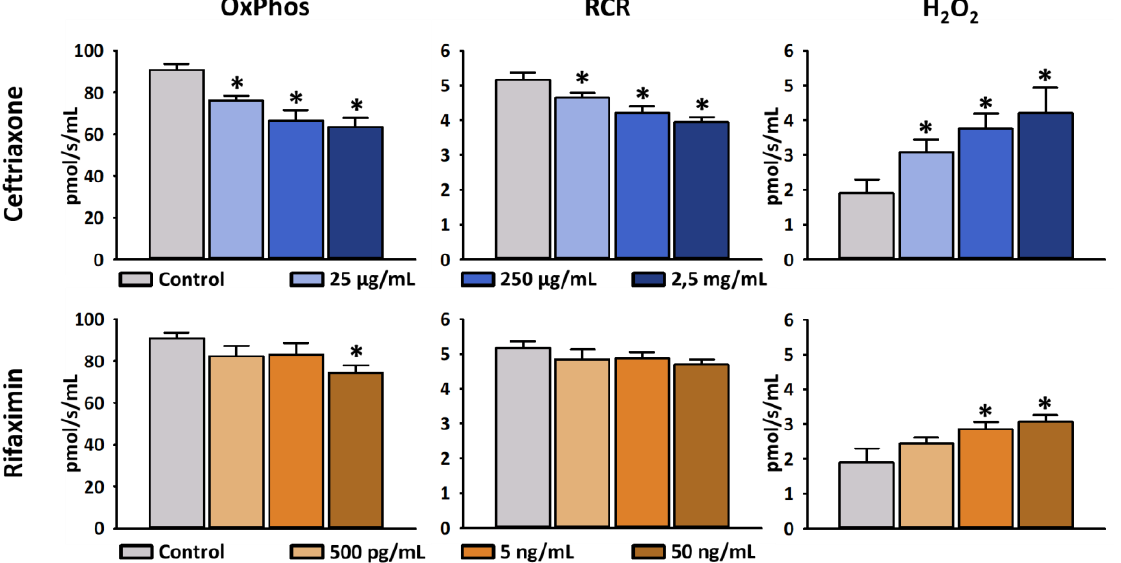
Figure 1. Effects of Ceftriaxone and Rifaximin on oxidative phosphorylation (OxPhos), respiratory acceptor control ratio (RCR) and hydrogen-peroxide (H 2 O 2 ) production of isolated mitochondria. Concentrations of antibiotics are based on their peak plasma concentration following the admin- istration of a single dose (250 µg/mL Ceftriaxone or 5 ng/mL Rifaximin) and tenfold higher or lower concentrations for comparison. Darker shades indicate higher concentrations. Blue columns: Ceftri- axone treatment; Orange columns: Rifaximin treatment; Data are presented as mean ± SEM. * p < 0.05 vs. control (one-way ANOVA, Holm – Sidak test) are considered as significant.